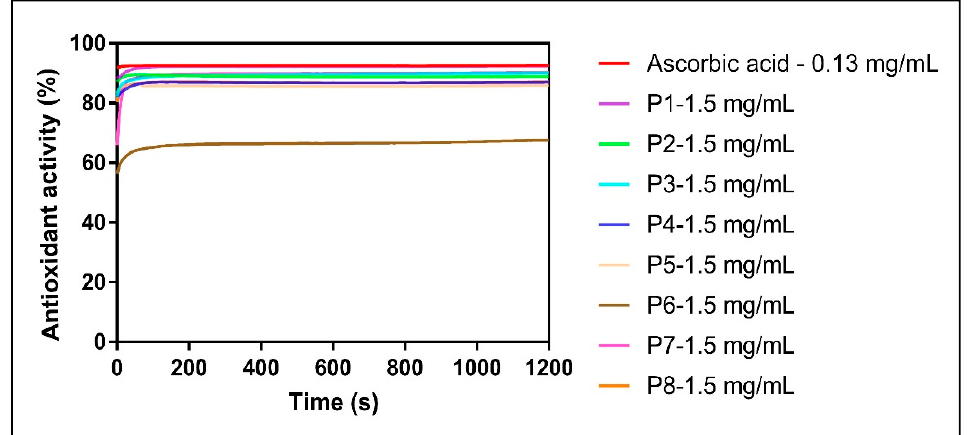
Figure 5. Time-dependency of radical scavenging activity of propolis (1.5 mg/mL) as compared with the standard antioxidant (DPPH assay).